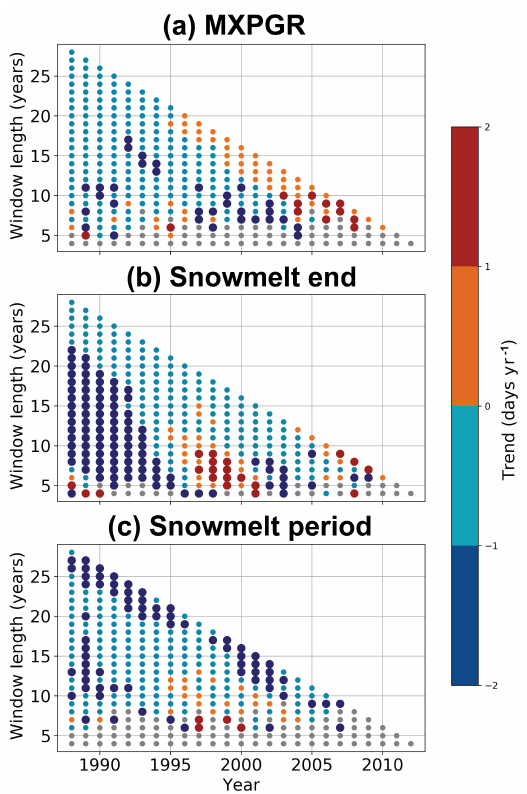
Figure 11. Impact of window length on measured trends in (a) MXPGR, (b) snowmelt end, and (c) snowmelt period over the en- tire study area. Each dot represents trends over a single window size (4–28 years) and start year (1988–2012) combination. Regressions are performed using the same clusters shown in Fig. 8. Only statisti- cally significant trends ( p < 0 . 05) are included in this analysis; gray dots indicate lack of significant trend. Larger dots indicate positive or negative trends larger than 1 day year − 1 . Trends in snowmelt period and snowmelt end dates are generally negative regardless of which years the trend is assessed over, excepting short periods in the late 1990s and 2000s. MXPGR dates are positive over short time periods starting in the late 1990s and negative over earlier time periods and longer time windows.